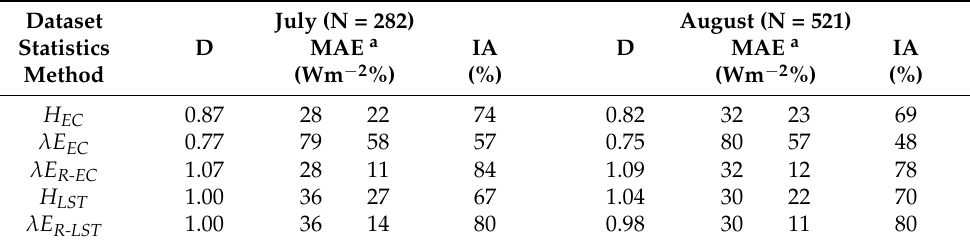
Figure 1. Accumulated surface flux estimates, H EC (squares), λ E EC (triangles) and ( H EC + λ E EC + G + S ) (circles), standardized by the net radiation (AFlux/ARn) for different friction velocity thresholds in July (solid) and August (open). Table 1. EC and LST sensible heat and latent heat flux estimates.